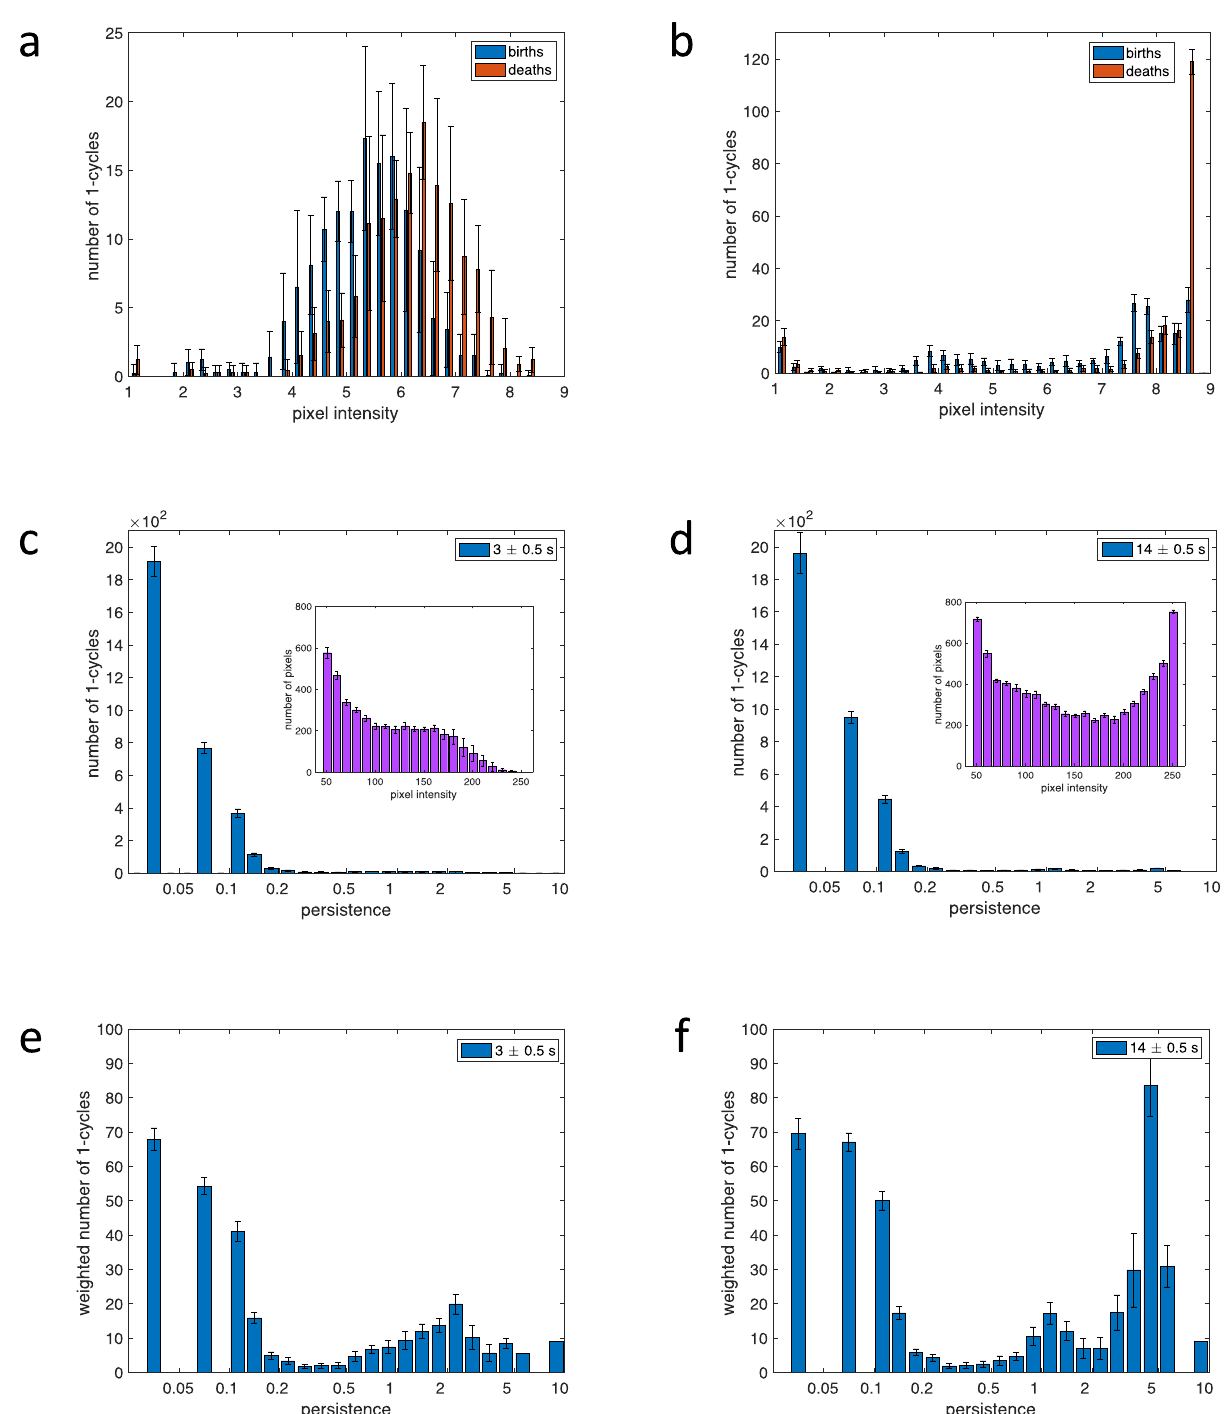
Fig. 3 Statistical analysis of persistence diagrams of the isotropic-nematic phase transition. The distribution of birth (blue) and death (orange) values for 1-cyles of 10 persistence diagrams at ( a ) t = 3 ± 0.5 s and ( b ) t = 14 ± 0.5 s. c, d Distribution of persistence of 1-cycles (blue) together with pixel intensities (purple) and ( e, f ) distribution of weighted persistence of 1-cycles at ( c, e ) t = 3 ± 0.5 and ( d, f ) t = 14 ± 0.5 s. The error bars represent standard